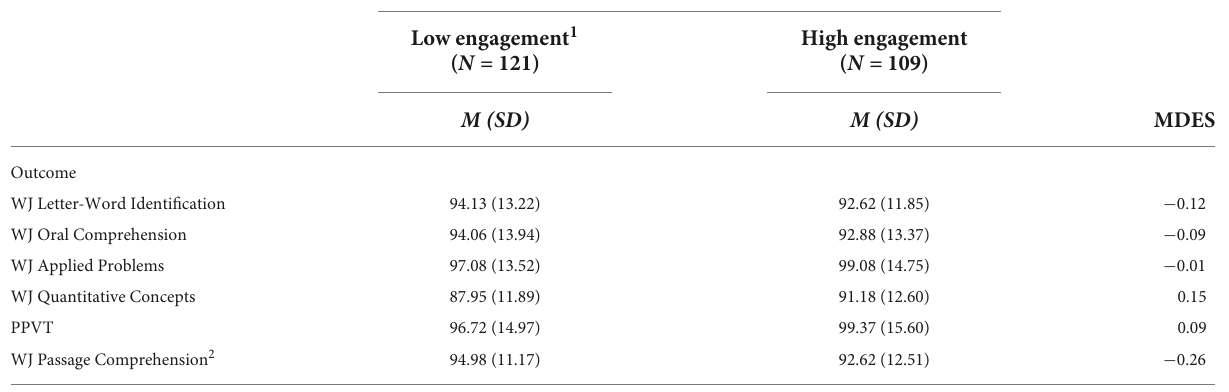
TABLE 5 Means and standard deviations for ED student assessments with lower versus higher engagement. Economically disadvantaged